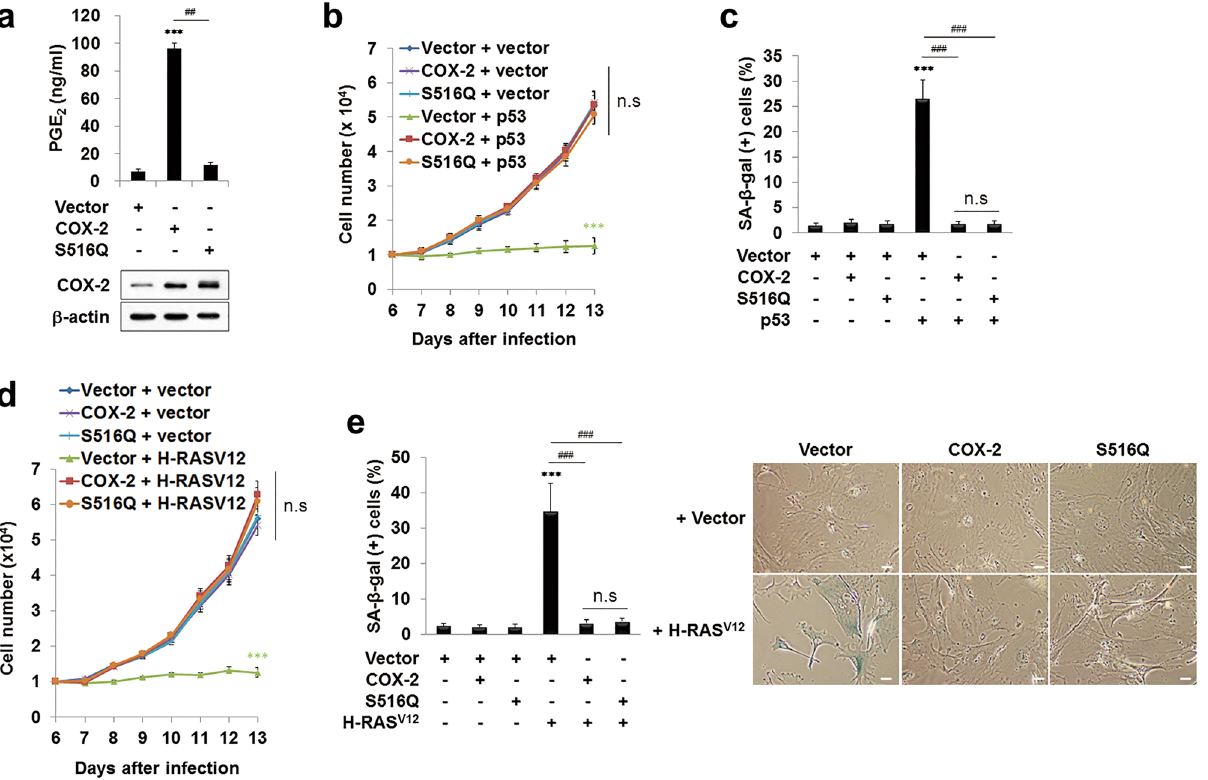
Figure 4. COX-2 inhibits the pro-senescent function of p53 and OIS by catalytic activity-independent mechanisms. ( a ) PGE 2 assay. MEFs were infected with retroviruses expressing COX-2, S516Q, or an empty vector as a control. PGE 2 concentration was measured in the conditioned medium (upper). Cell lysates were subjected to western blot analysis. β-actin was used as a loading control (lower). Data are means ± SD ( n = 6; *** P < 0.001 vs. Vector; ## P < 0.01). ( b , d) MEFs were infected with retroviruses as indicated. 1 × 10 4 cells were seeded and the number of cells was counted. Data are means ± SD ( n = 6) in ( b ) and SE ( n = 11) in ( d ) (*** P < 0.001 vs. Vector + vector; n.s, not significant at the final day). ( c , e ) SA-β-gal (+) cell ratios were calculated and the representative data were shown. Data are means ± SD ( n = 12 in ( c ) and n = 9 in ( e )) (*** P < 0.001 vs. Vector; ### P < 0.001; n.s, not significant). Scale bars = 13.6